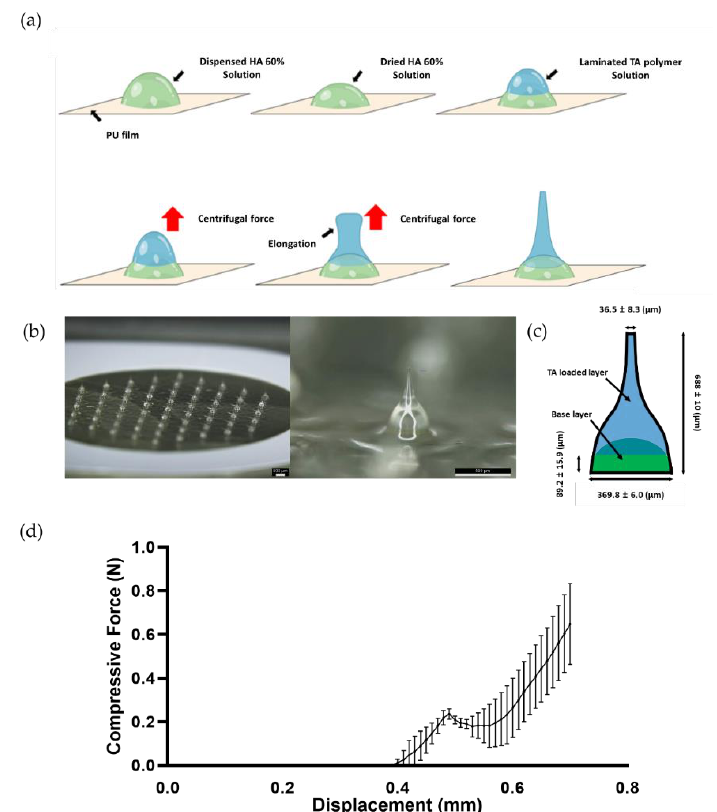
Figure 2. Schematic of the TA-loaded dissolving microneedle (TA-DMN) fabrication process and evaluation of physical properties of TA-DMNs. ( a ) TA containing solution droplet (blue) laminated on dried HA droplet (green) and centrifugal force exertion on two-layered droplets at low temperature and vacuum conditions. ( b ) Micrographic image of TA-DMN array on the patch and enlarged micrographic image of TA-DMN; the scale bar represents 500 µm. ( c ) Geometric specifications of TA-DMNs consisting of a TA-loaded layer (blue) and an empty base layer (green) (mean ± standard deviation, n = 3 in each type). ( d ) Fracture force analysis of TA-DMNs ( n = 3).